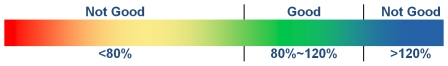
Criterion for evaluation of complementation similarity degree.If a similarity degree is between 80% and 120%, the complementation result it represents is viewed as “good”; otherwise the complementation result is viewed as “not good”.